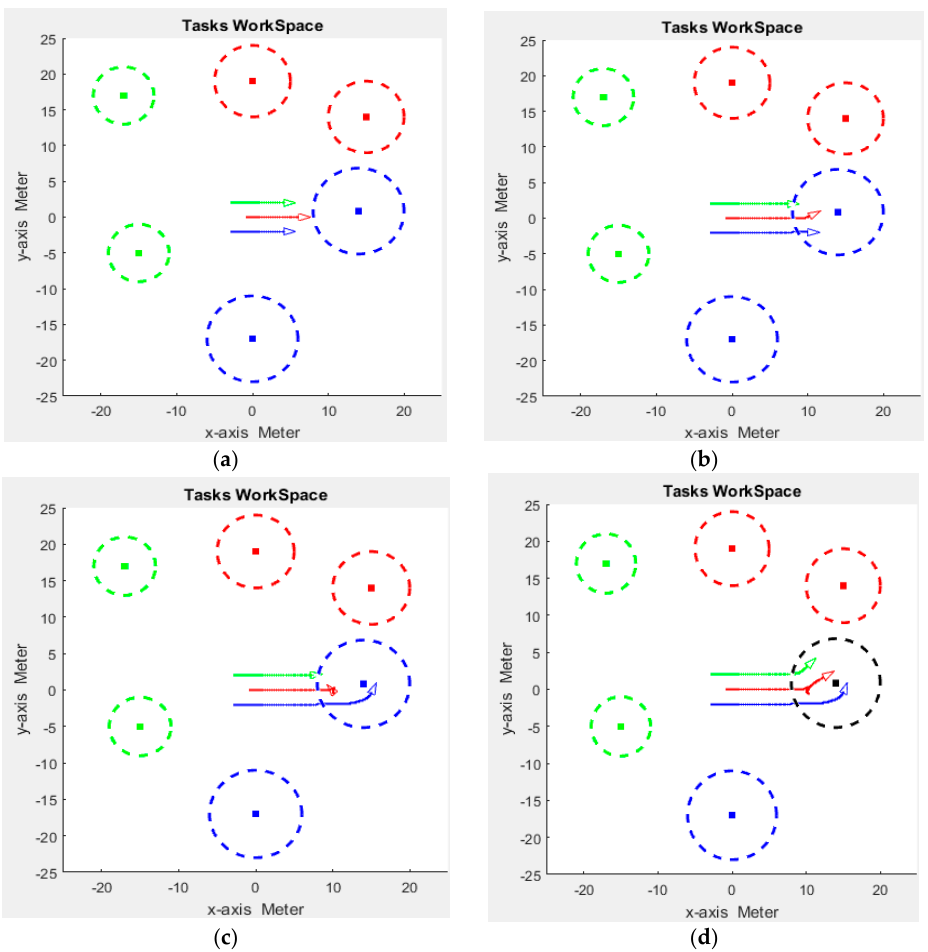
Figure 3. ( a ) Robots in Search phase; ( b ) robots switch to Task phase; ( c ) robots switch to Execution phase; and ( d ) task